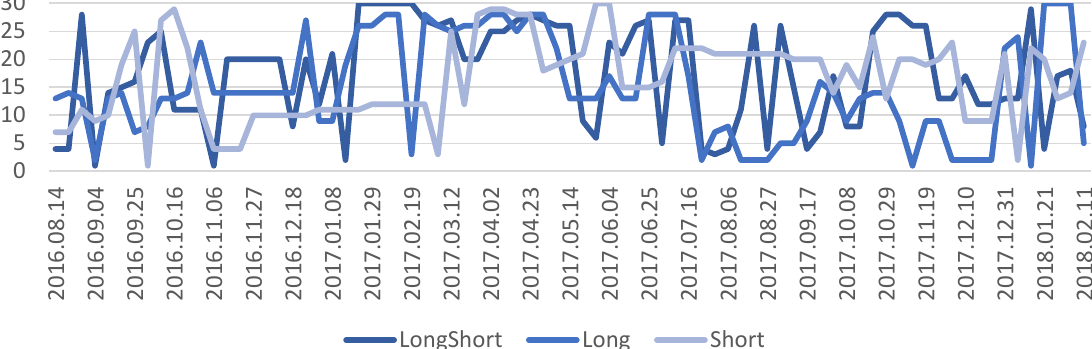
Figure 12. A diagram that shows the values of the backtesting periods (in number of weeks) for the three PIVOT systems for